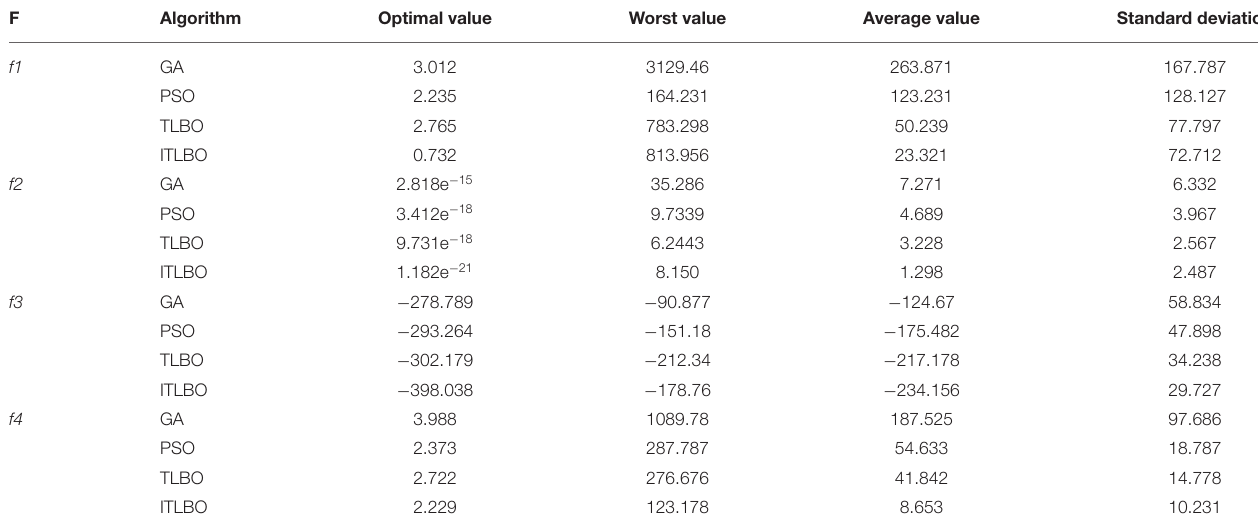
TABLE 1 | Comparison of four function